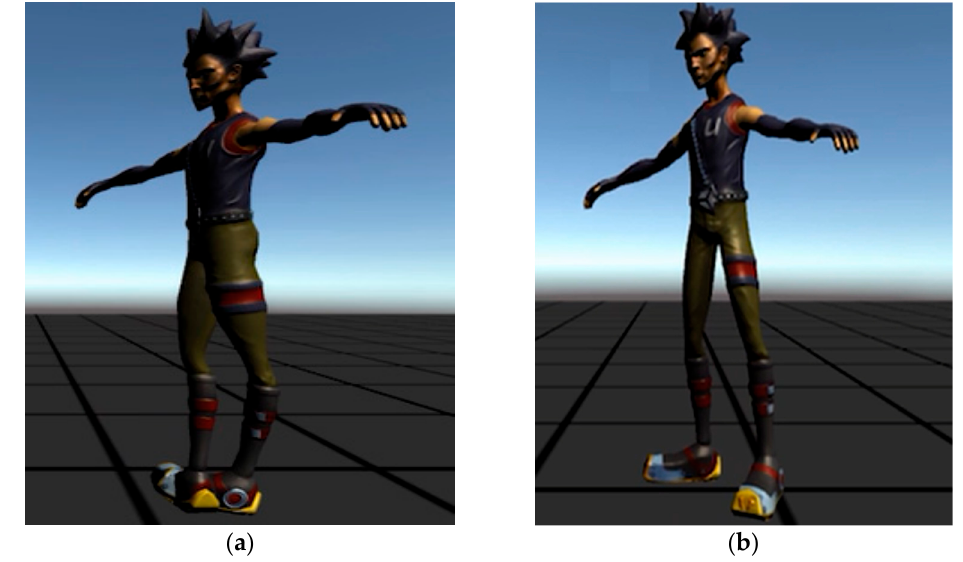
Figure 16. Sensing measurement errors of the sensor nodes were calibrated when the T-pose calibration was performed. ( a ) All sensor nodes were calibrated well during the T-pose procedure. ( b ) One sensor node attached to the right thigh was not calibrated well, and a sensing error was derived in the pitch direction.